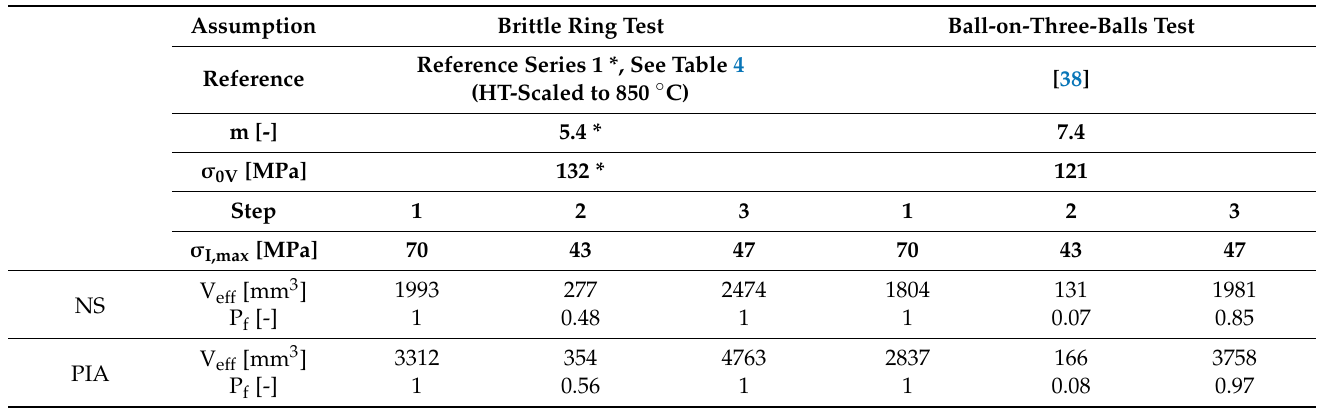
Table 6. Weibull parameters, effective volume and the resulting normalized strength of pre-treated brittle ring